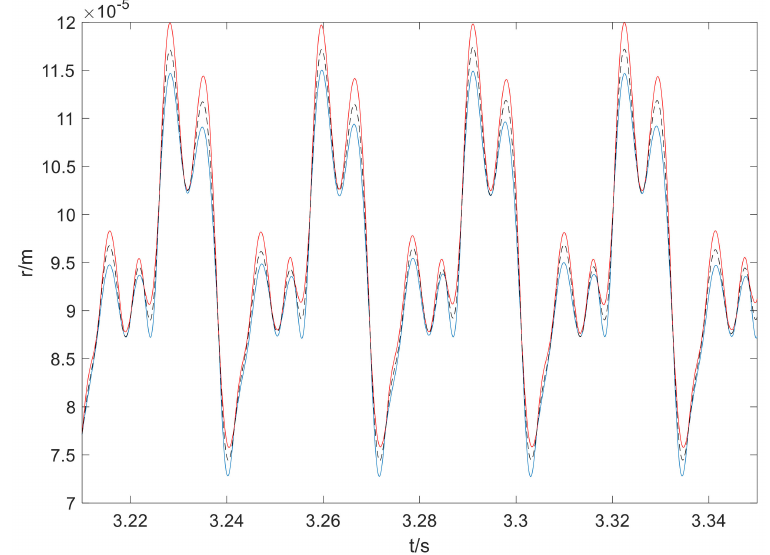
Figure 8. Vibrations of the rubbing rotor with 10% bounded friction coe ffi cient uncertainty: blue solid line = lower bound; red solid line = upper bound; black dotted line = deterministic curve.